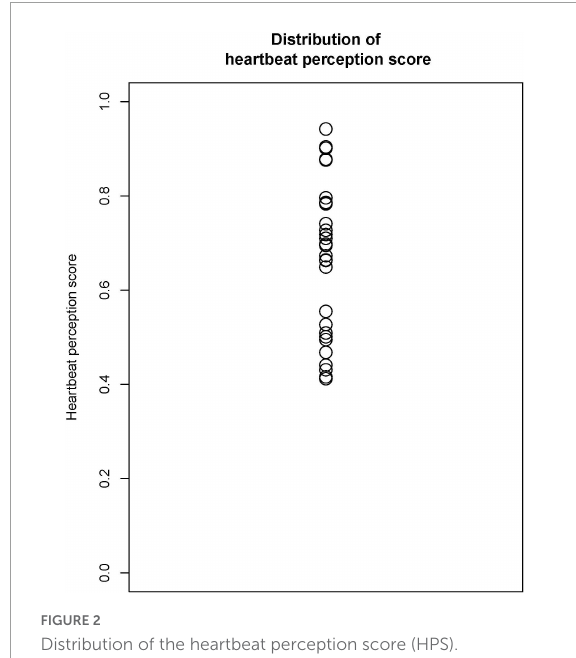
FIGURE2 Distribution of the heartbeat perception score (HPS). Mean = 0.667, SD =